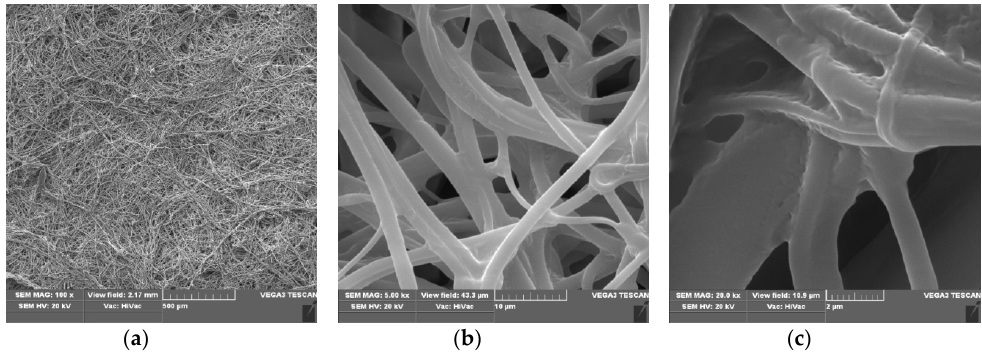
Figure 3. The SEM result of Polylactide nonwoven with fosfomycincoating (PLA-MOD), magnification 100× ( a ), 5000× ( b ) and 20000× ( c ).